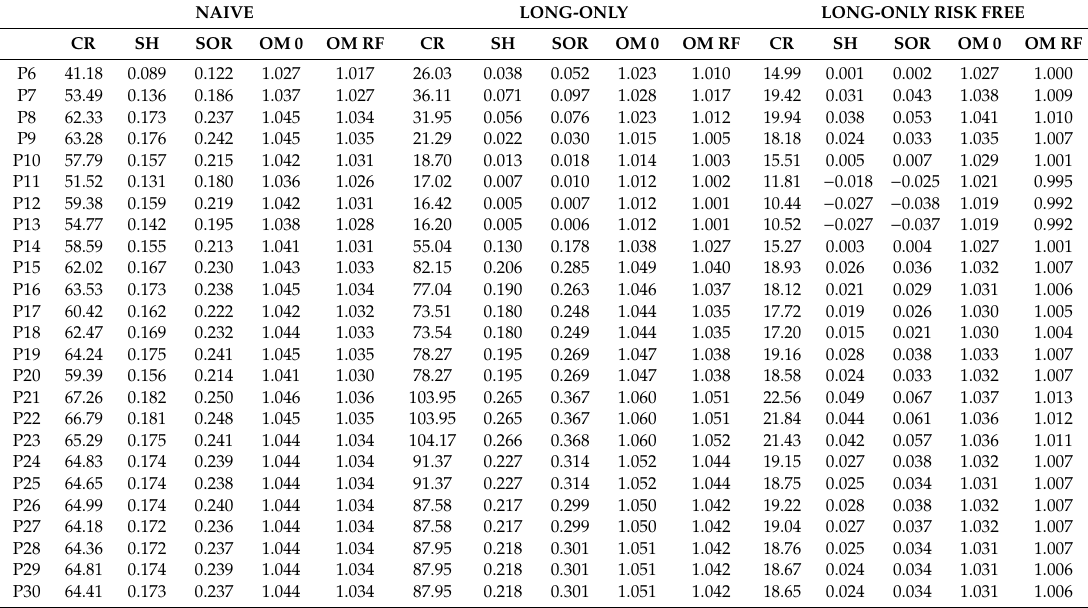
Table 6. Performance from vice portfolios using a 5-year rolling